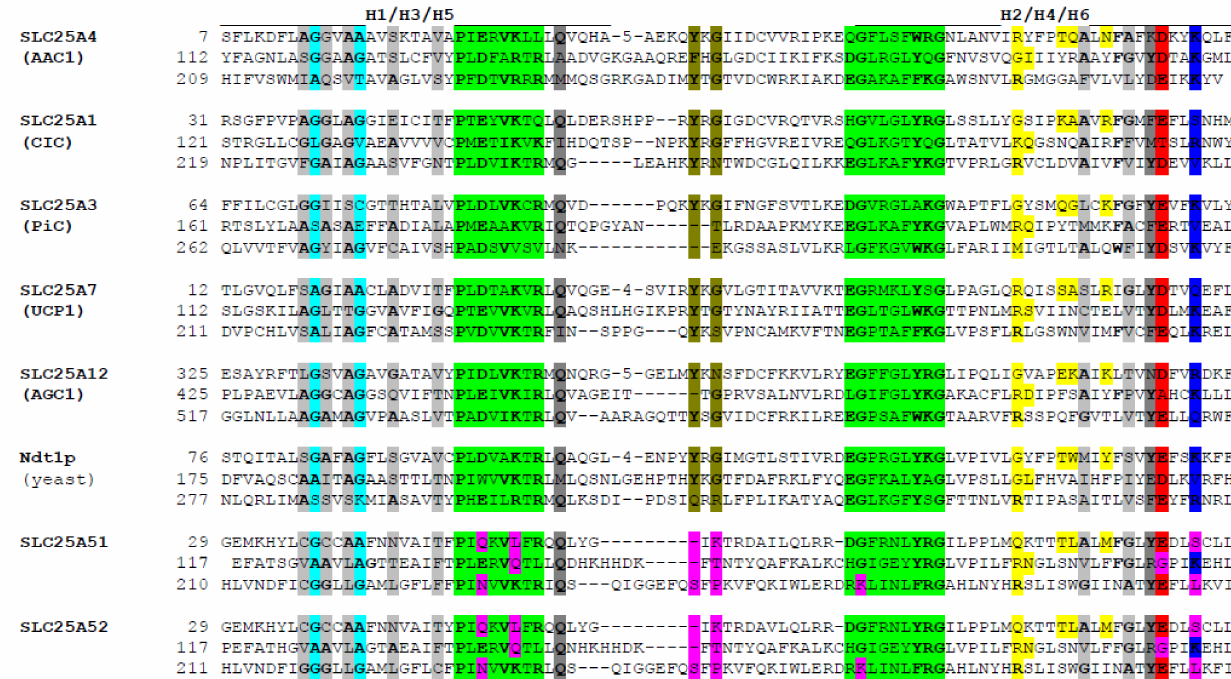
Figure 2. Sequence comparison of the three mitochondrial carrier domain repeats in nucleotide transporter SLC25A4 (ADP/ATP carrier 1, AAC1), carboxylate transporter SLC25A1 (citrate carrier, CIC), phosphate transporter SLC25A3 (PiC), proton transporter SLC25A7 (uncoupling protein 1, UCP1), amino acid transporter SLC25A12 (aspartate-glutamate carrier 1, AGC1), NAD + transporter Ndt1p ( S. cerevisiae ), SLC25A51, and SLC25A52. The following sequence features are indicated: position of the transmembrane helices H1-6 (a line above the sequences), the conserved residues (bold), the helical packing GXXXG motif (cyan), other helical packing small amino acids (light grey), the signature motif sequences (green), the glutamine and tyrosine braces (dark grey), the cardiolipin-binding motif 1 (olive), the contact point residues of the proposed substrate binding site (yellow), and the negatively (red) and positively (blue) charged residues of the cytosolic gate. The distinct sequence variations in SLC25A51 (and SLC25A52) discussed in the text are indicated in